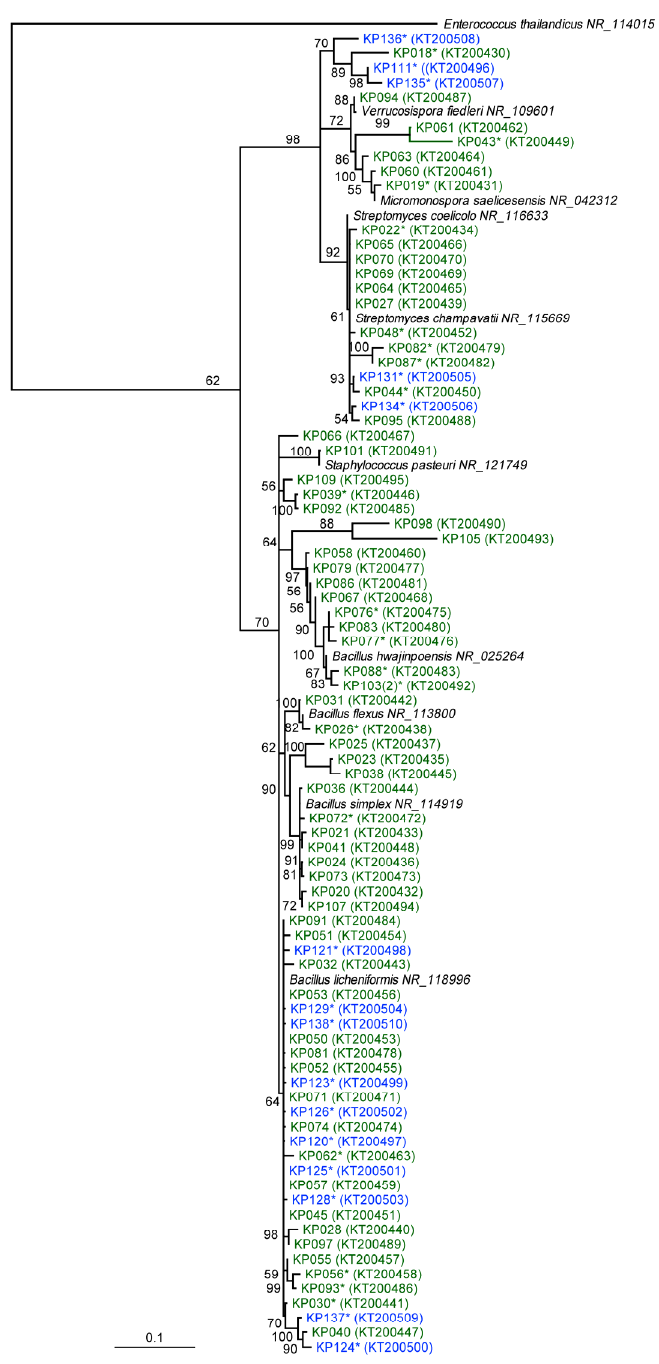
Figure 1. Neighbour-joining tree based on almost complete 16S rRNA gene sequences, showing the phylogenetic relationships between 81 Scottish and Antarctic bacterial isolates (KP011, KP122, KP130 and KP133 were excluded from the tree) with NCBI accession numbers in brackets. Bootstrap support >50 % based on a neighbour-joining analysis of 1000 resampled datasets is shown. Scale bar, 0.1 substitutions per nucleotide position. * strains subjected to metabolite comparison through molecular networking. Branches are colour-coded according to their isolation location (Scotland, Green; Antarctica, Blue) for each bacterial isolate.